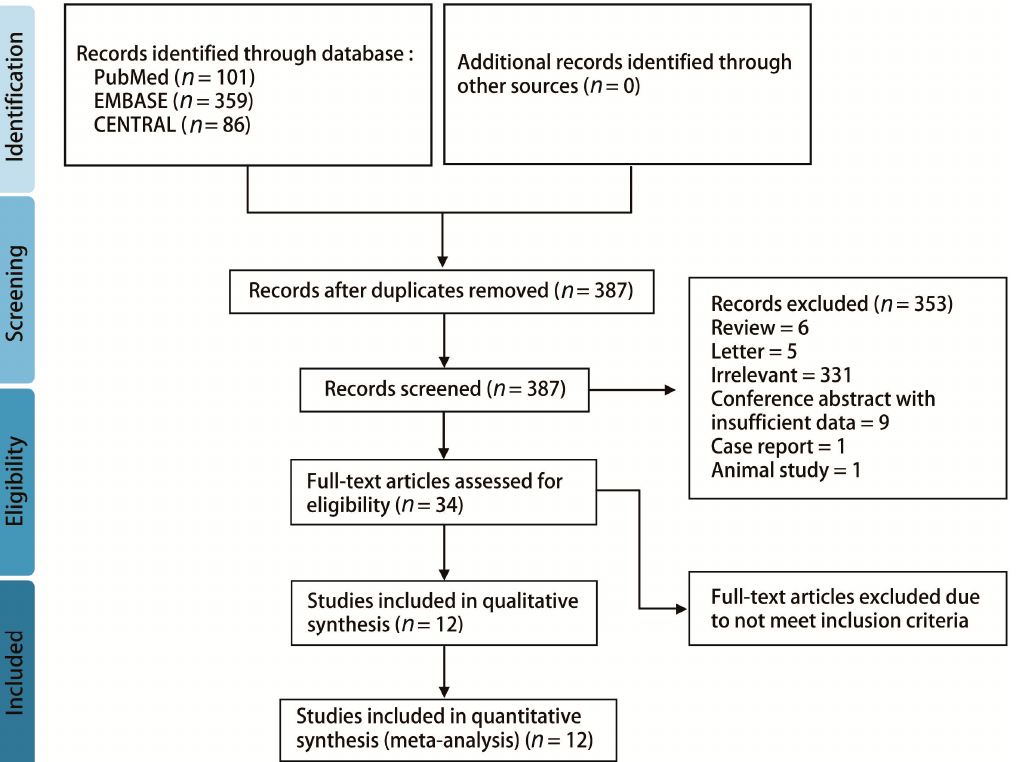
Figure 1. Preferred reporting items for systematic review and meta-analysis (PRISMA) flow diagram.